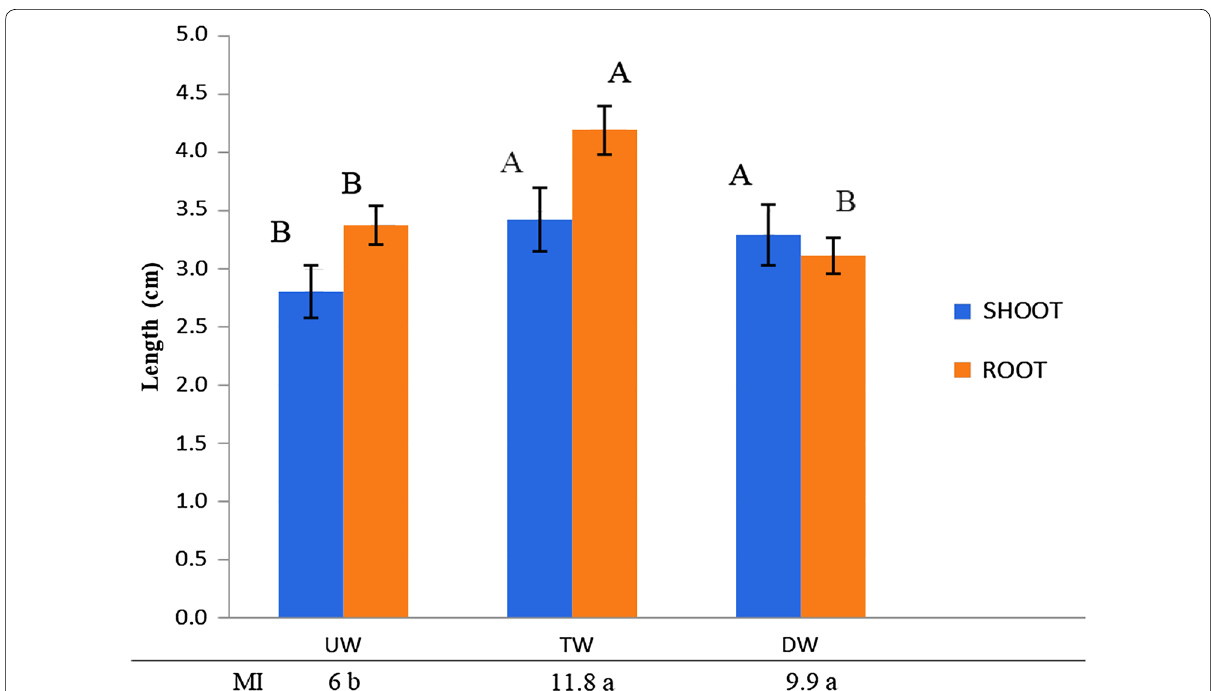
Fig. 4 A. cepa root and shoot growth following seed imbibition with untreated or treated water from the Cildáñez stream. UW, untreated water: Cildáñez stream water before the bioprocess; TW, treated water: Cildáñez stream water after a 5-day bioprocess using the confined system (red PLA devices); DW: distilled water. MI: mitotic index of root tip cells. Measurements were performed as described in “Materials and methods”. Letters indicate significant differences for the same plant organ (p <